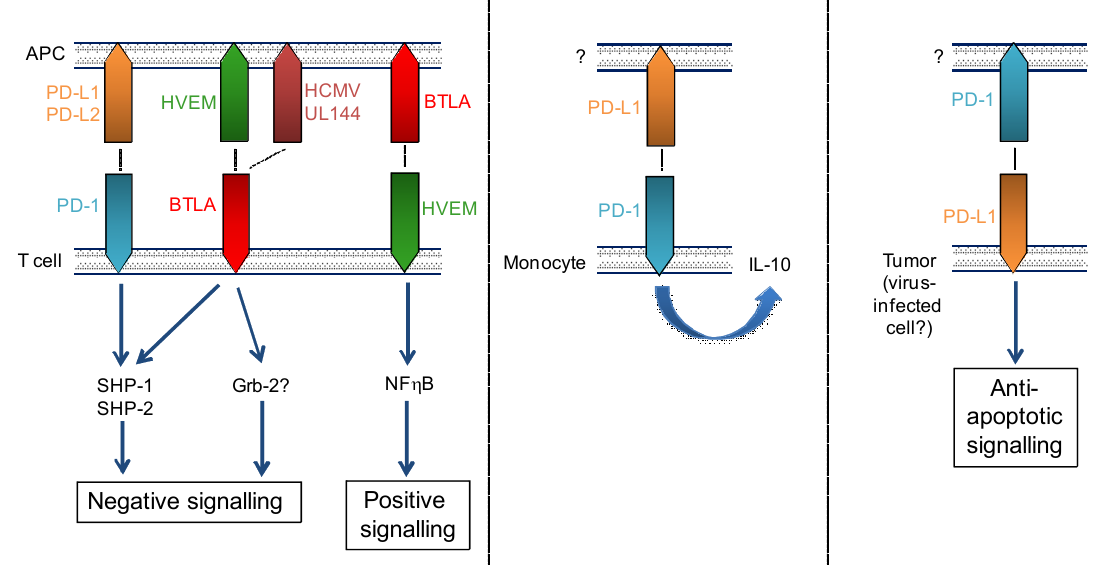
Figure 1. PD-1, BTLA and their mammalian and herpesvirus ligands. Left: T cell-expressed PD-1 and BTLA induce inhibitory signalling following binding of their respective mammalian and viral ligands. BTLA binding to T cell-expressed HVEM elicits NF  B-induced pro-inflammatory/pro-survival signalling. Middle: Up-regulation of PD-1 expression by monocytes is observed in HIV infection and PD-1 ligation induces